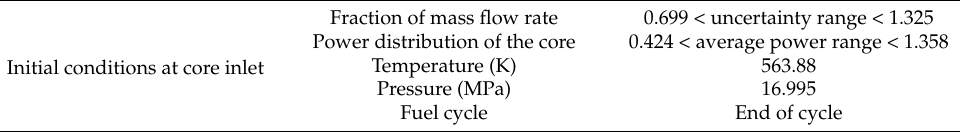
Figure 8. Three-dimensional overview of a fuel assembly. Table 2. Initial conditions for sub-channel analysis. Table 2. Initial conditions for sub-channel analysis.